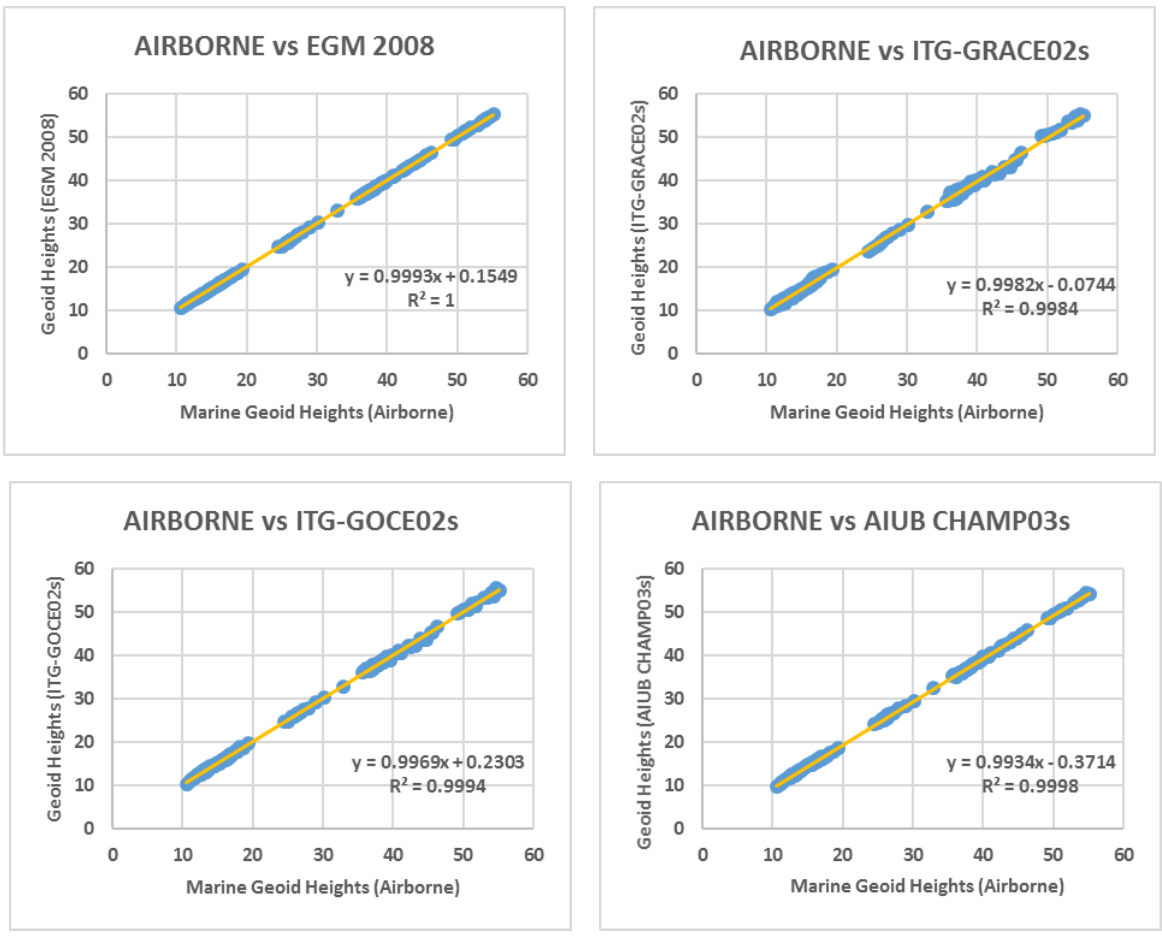
Figure 6. The correlation between the airborne gravity data and the GGMs (EGM 2008, ITG-GRACE 2010s, ITG-GOCE 02s and